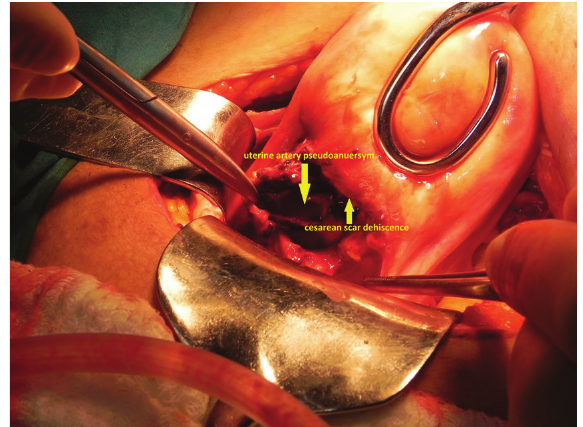
Figure4:ACSDwasinspectedandthesourceofhigh-flowbleeding was found to be the aneurysmatic formation associated with the right uterine artery, within the uterine